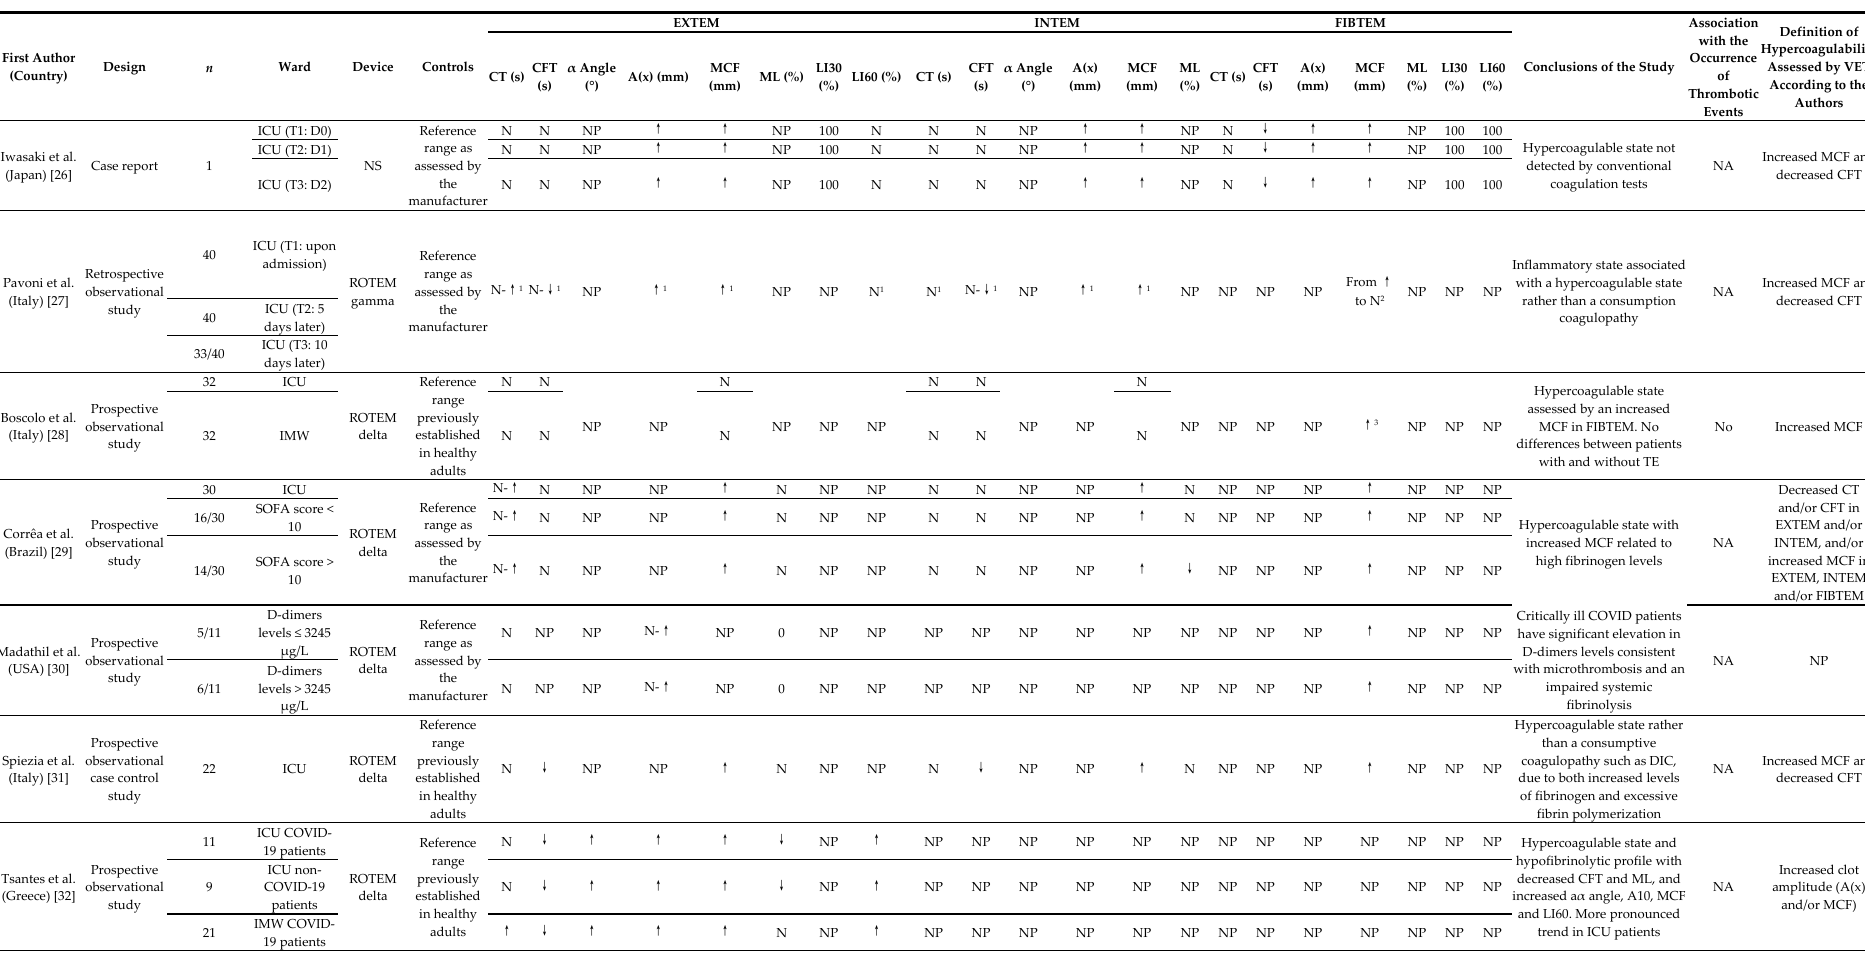
Table 5. Main findings of studies reporting ROTEM results (except APTEM and TEM-tPA assays).